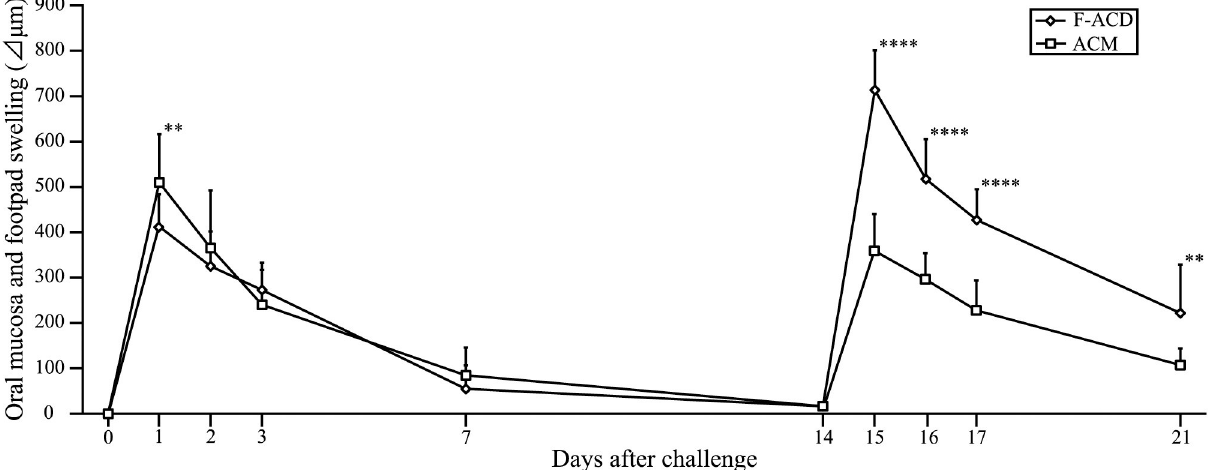
Fig 9. Comparison of swelling between the oral mucosa and footpad of Ni-induced allergic mice. The swelling of ACM and F-ACD mice at 1, 2, 3, and 7 days after the first and second challenges. At day 0 and day 14 after sensitization, the challenge was performed in ACM and F-ACD mice. Swelling at day 1 after the first challenge was significantly increased in ACM mice compared with F-ACD mice. Swelling from 1 to 7 days after the second challenge was significantly increased in F-ACD mice compared with ACM mice. Bars and error bars indicate the mean plus standard deviation. Statistical significance was tested by the Mann–Whitney U- test ( �� p < 0.01, ���� p < 0.0001).